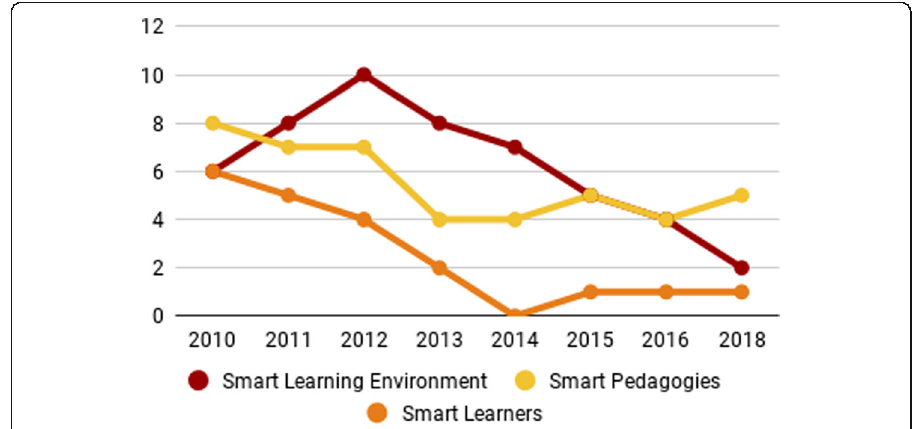
Fig. 2 Keyword frequency of smart learning elements from 2010 to